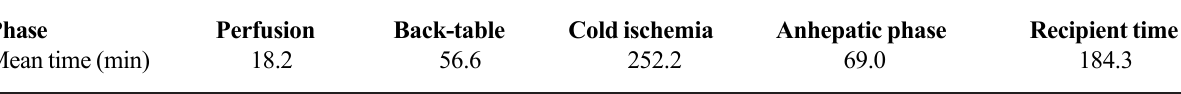
TABLE 1 - Mean time in each phase of the procedure Phase Perfusion Back-table Cold ischemia Anhepatic